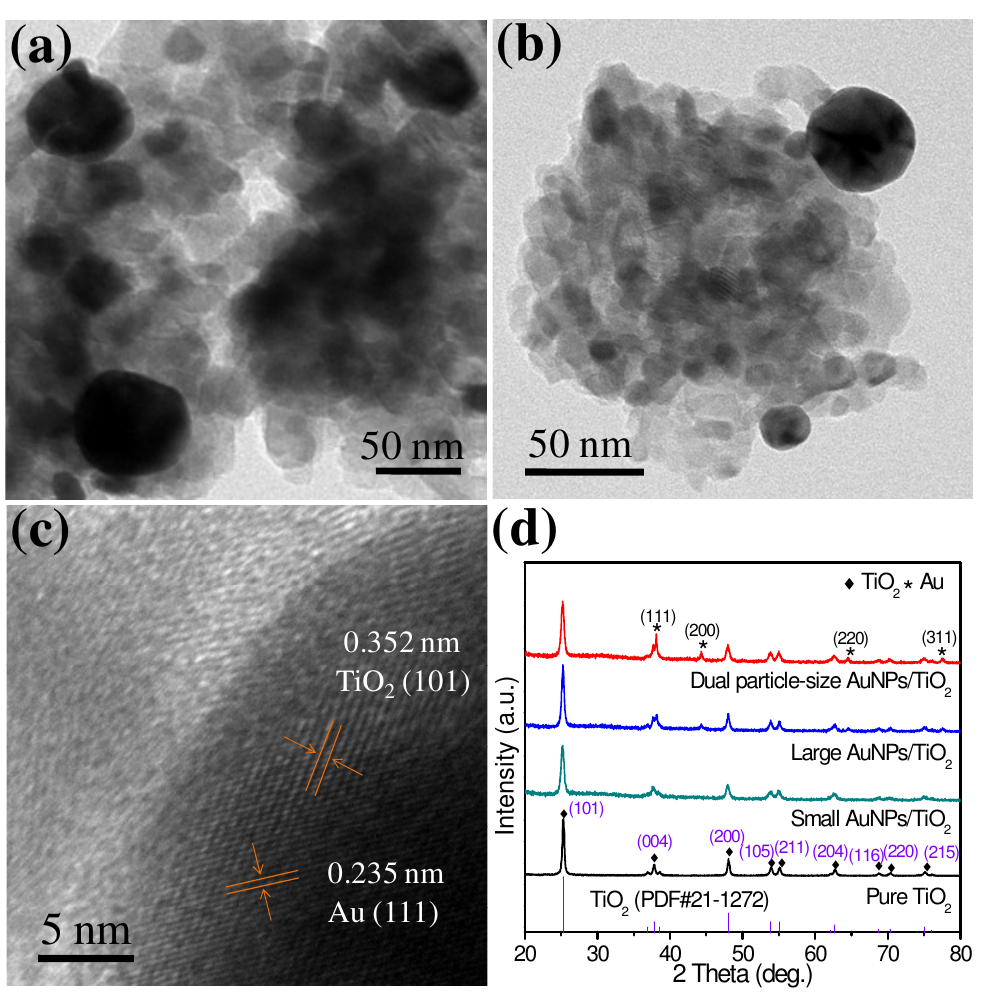
Figure 3. ( a , b ) TEM and ( c ) HRTEM photographs of 2.1 wt% dual particle-size AuNPs/TiO 2 hybrids. ( d ) X-ray diffraction (XRD) patterns of pure TiO 2 , small AuNPs/TiO 2 , large AuNPs/TiO 2 , and dual particle-size AuNPs/TiO 2 hybrids.